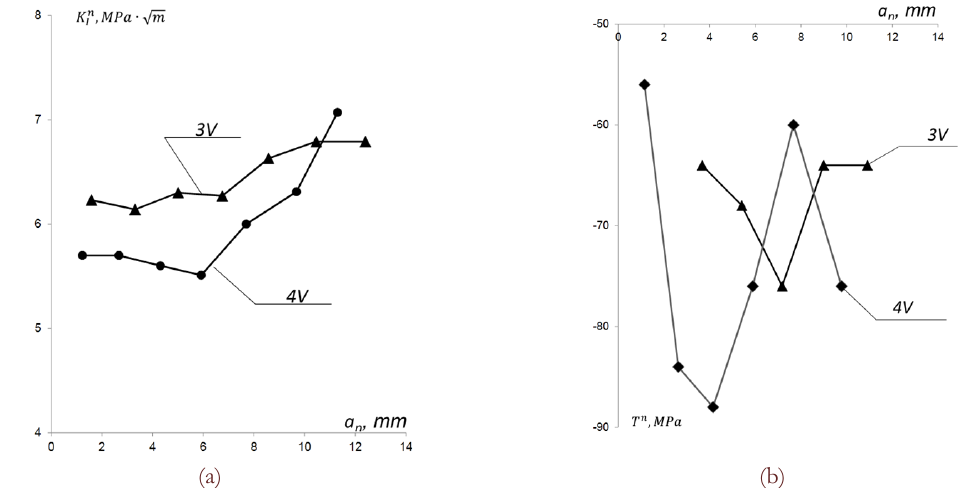
Figure 4: Dependencies of SIF K (a) and T-stresses T (b) from total notch length for specimen #3V and specimen I